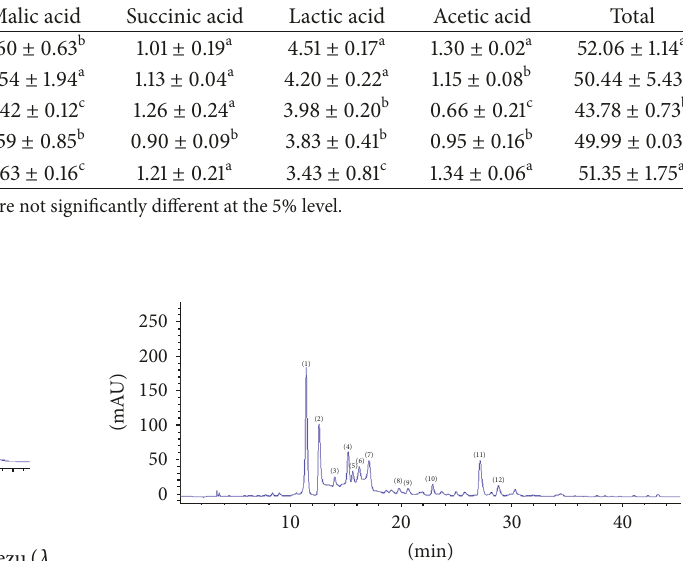
Figure 1: Representative chromatogram of organic acid in umezu ( 𝜆 = 210 nm). (1) Oxalic acid; (2) citric acid; (3) malic acid; (4) succinic acid; (5) lactic acid; (6) acetic acid; (7) unknown.